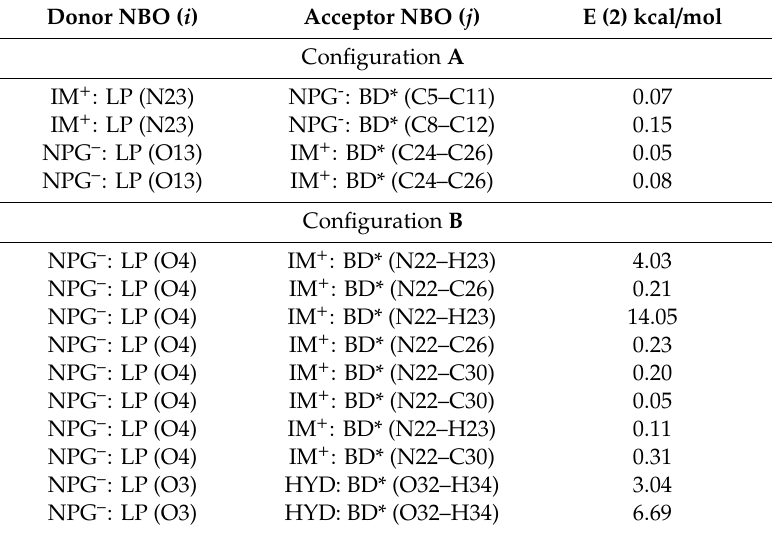
Table 5. Results of NBO analysis of donor–acceptor interaction in IM + –NPG − –HYD , determined using the second-order perturbation